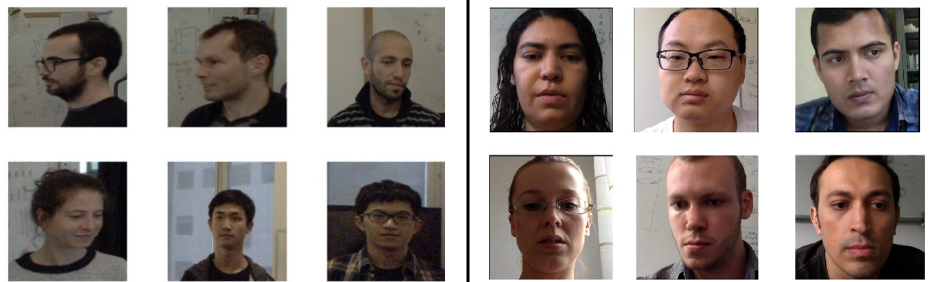
Figure 6. Some pictures from the Gaze360 and MPIIFaceGaze datasets. ( Left ) Gaze360; ( Right ) MPI-